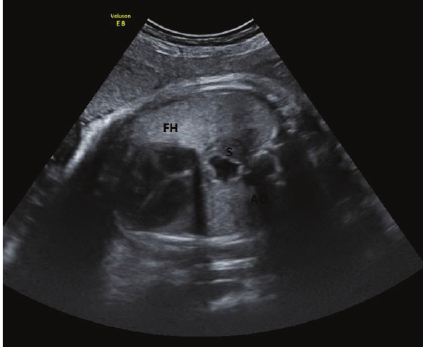
Figure1:Transverseviewofthefetalthoraxwithananecoechogenic mass behind the fetal heart (FH). Ao: aorta; S: stomach.